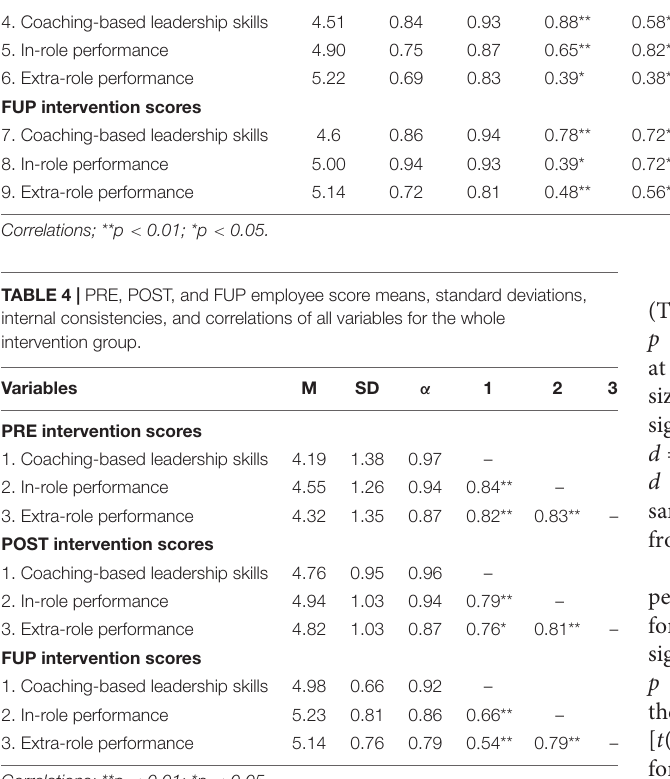
TABLE 3 | PRE, POST, and FUP supervisor score means, standard deviations, internal consistencies, and correlations of all variables for the whole intervention group. Variables